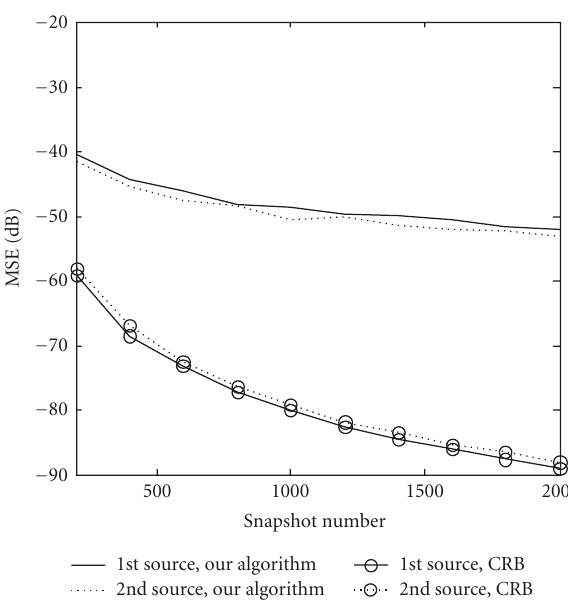
Figure 4: Estimation MSE of the elevations versus input SNR.